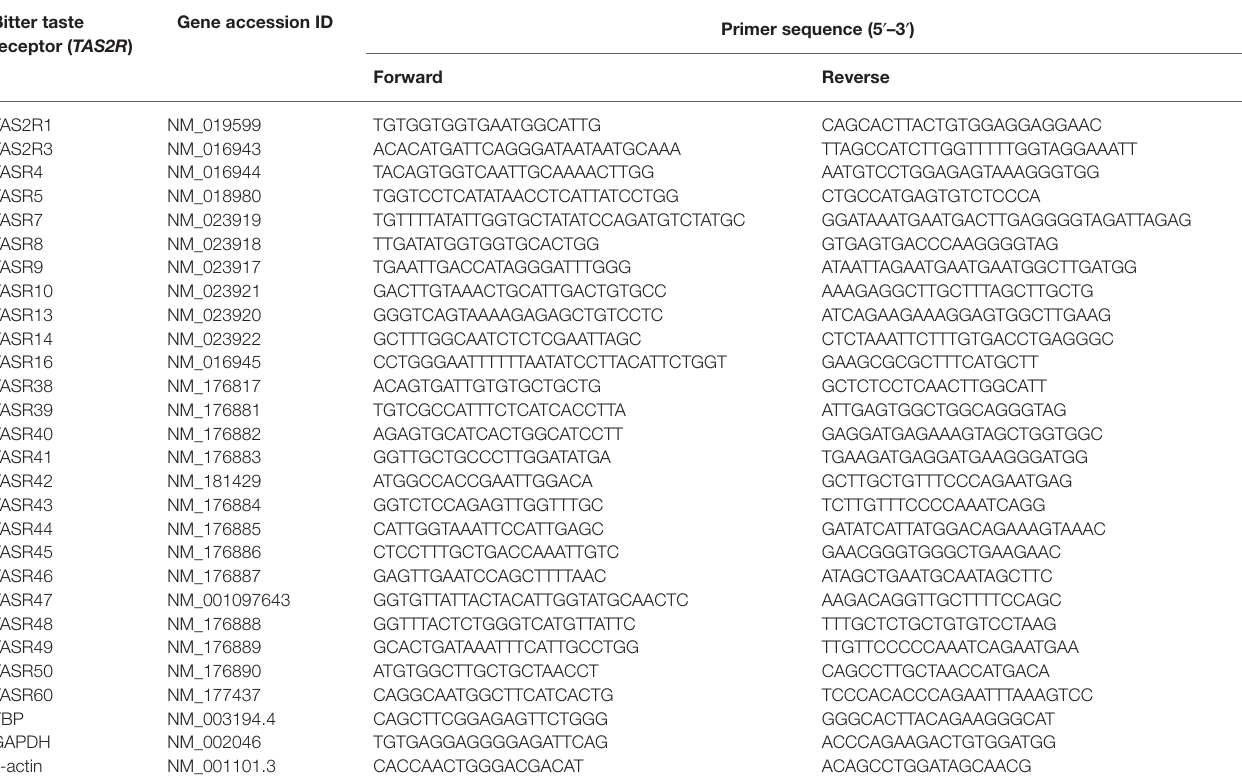
TABLE 1 | DNA primer sequences used to detect human T2R in HPAEC (based on Upadhyaya et al., 2014). Bitter taste receptor ( TAS2R